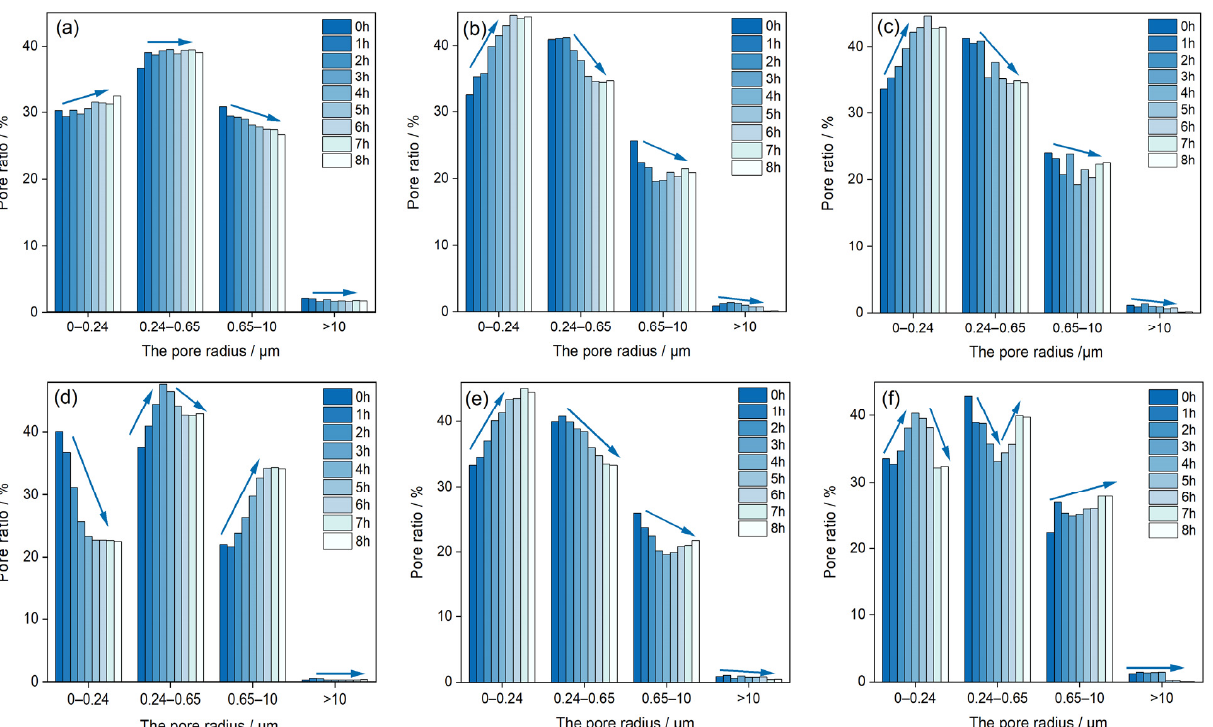
Figure 8. Internal pore distribution of samples with different concentrations of magnesium sulfate solution in the leaching process: ( a ) 0.0%; ( b ) 2.5%; ( c ) 3.0%; ( d ) 3.5%; ( e ) 4.0%; ( f ) 4.5%.